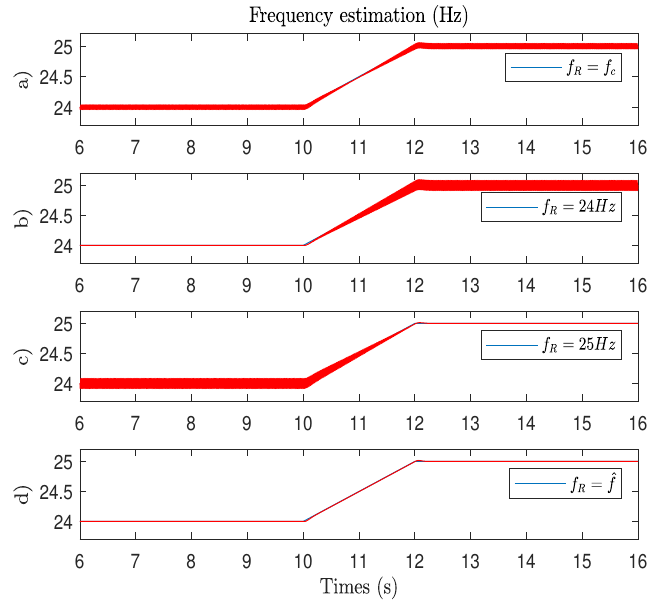
Figure 9. Estimated Frequency: sinusoidal signal with ramp frequency from 24 Hz to 25 Hz. ( a ) f R = f c , ( b ) f R = 24 Hz, ( c ) f R = 25 Hz, ( d ) f R = ˆ f